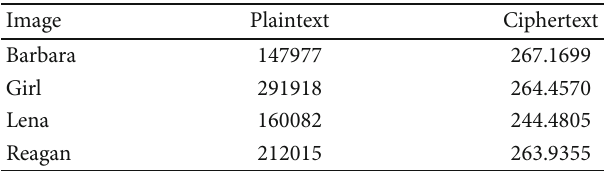
Table 5: NPCR and UACI test results